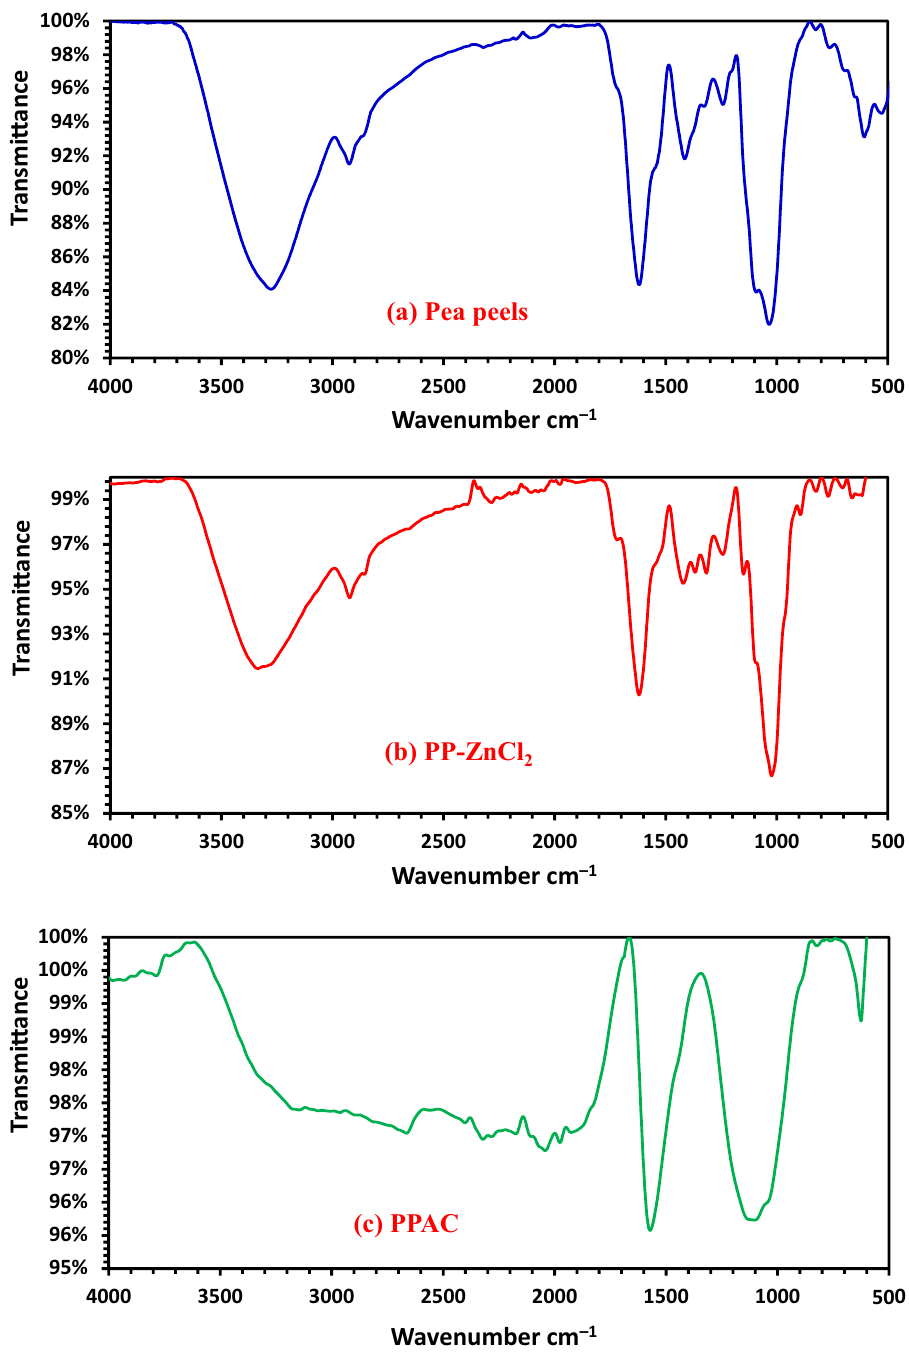
Figure 2. FTIR analysis of ( a ) Pea peels, ( b ) PP–ZnCl 2 , ( c ) PPAC prepared at 800